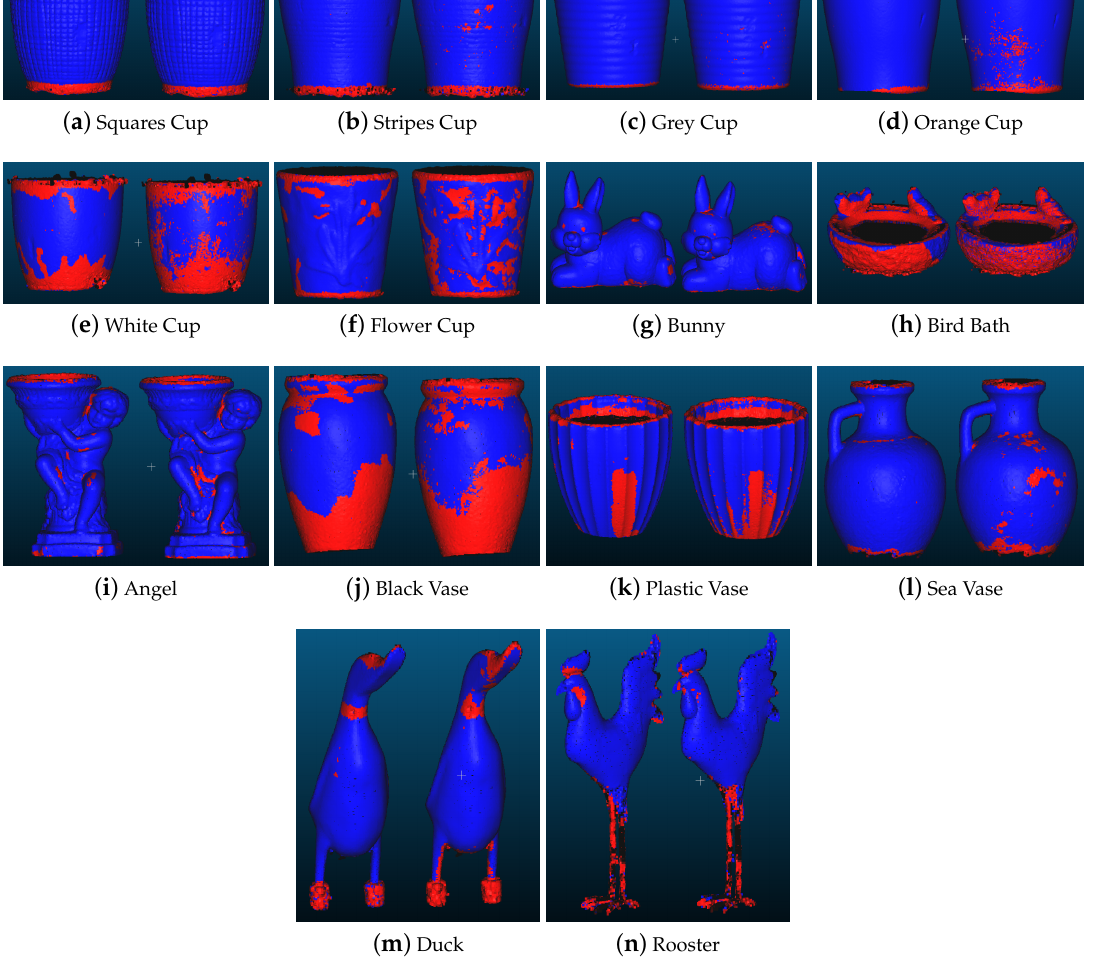
Figure 12. The annotated ground truth vertices on the left and the same classified vertices using our proposed method on the right. The noise vertices are colored red, while the non-noise ones are